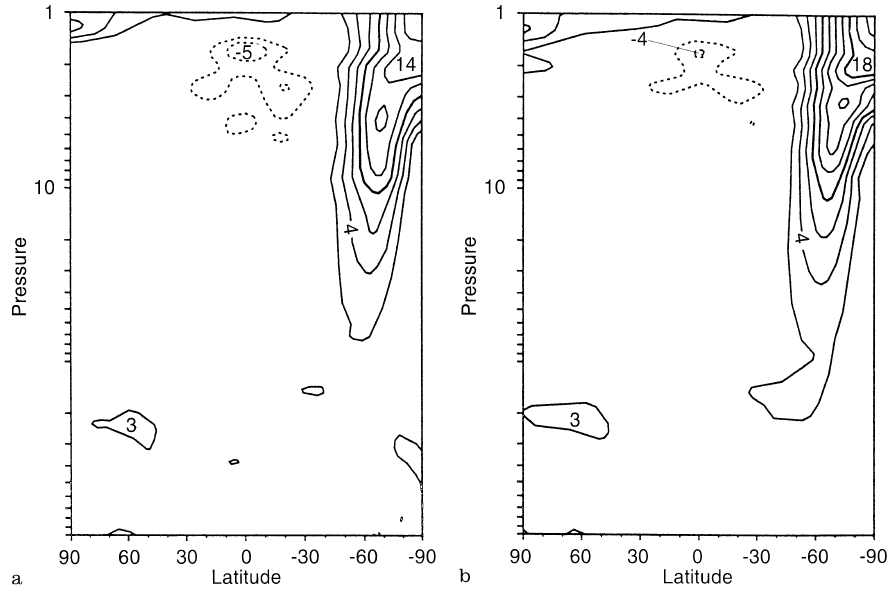
Fig. 9a, b. Zonal mean di(cid:128)erence of temperature for July between a the experiments GWDS41 and GWD31, and b the experiments GWDT41 and GWD31; contour interval 2 (cid:14) , the dotted lines represent